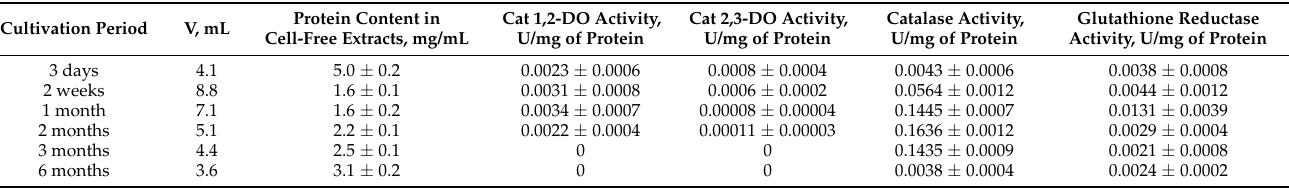
Table 1. Enzymatic activity of vegetal and resting cells of bacteria G. polyisoprenivorans (sample, the cells were cultured with stirring for three days, and then stored under stationary